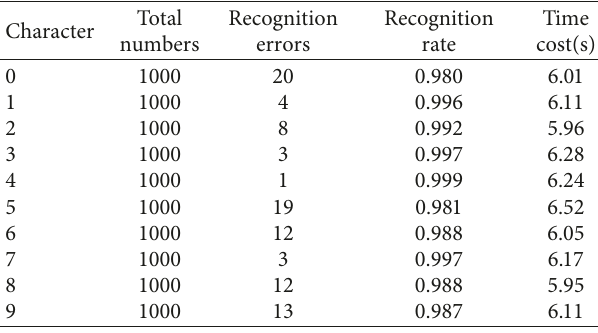
Table 1: Test results of CNN identification.